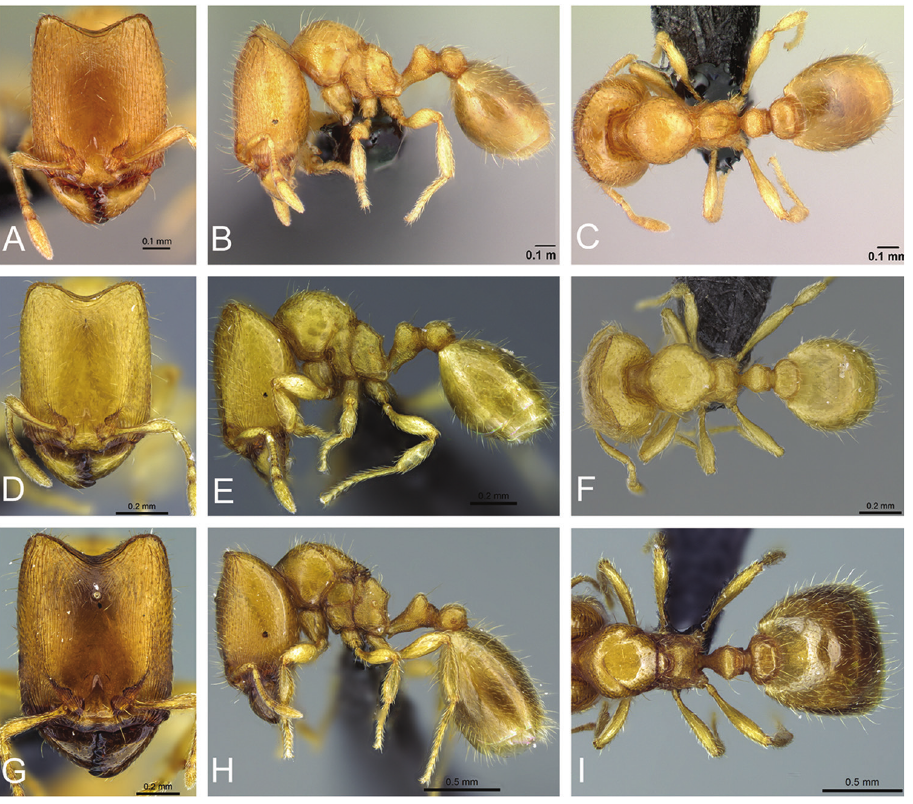
Figure 63. Intermediates of Carebara sampi . Major workers, CASENT0018045: A head in full-face view B body in profile view C body in dorsal view. CASENT0030374: D head in full-face view E body in profile view F body in dorsal view. CASENT0031267 G head in full-face view H body in profile view I body in dorsal